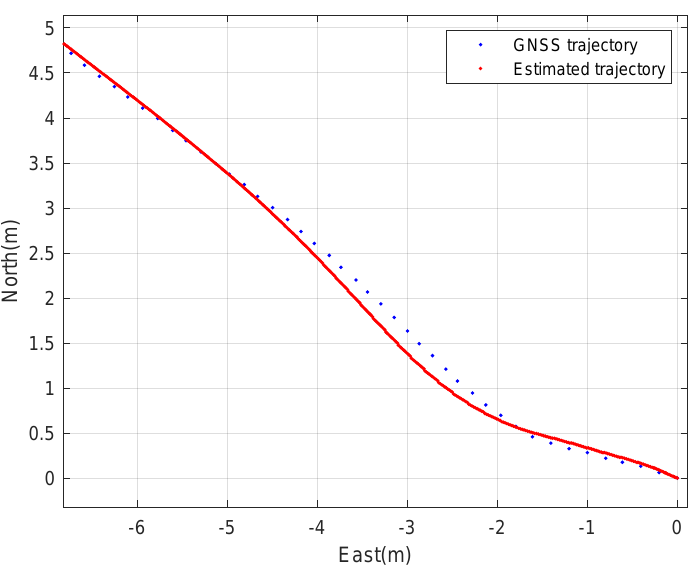
Figure 11. The expanded 2D trajectory of the rover: a straight driving